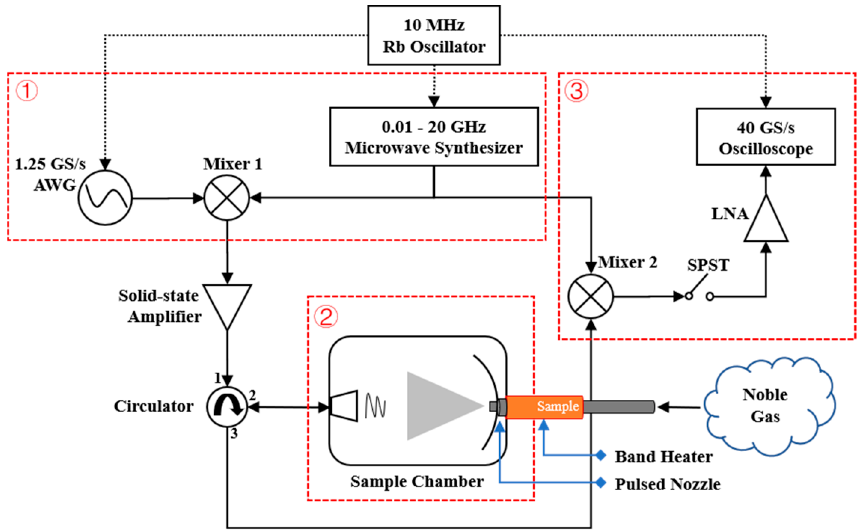
Figure 1. The schematic diagram of the cp-FTMW spectrometer, which is divided into three parts: (1) microwave signal source; (2) sample vacuum chamber; (3) signal detection system. (1) microwave signal source; (2) sample vacuum chamber; (3) signal detection